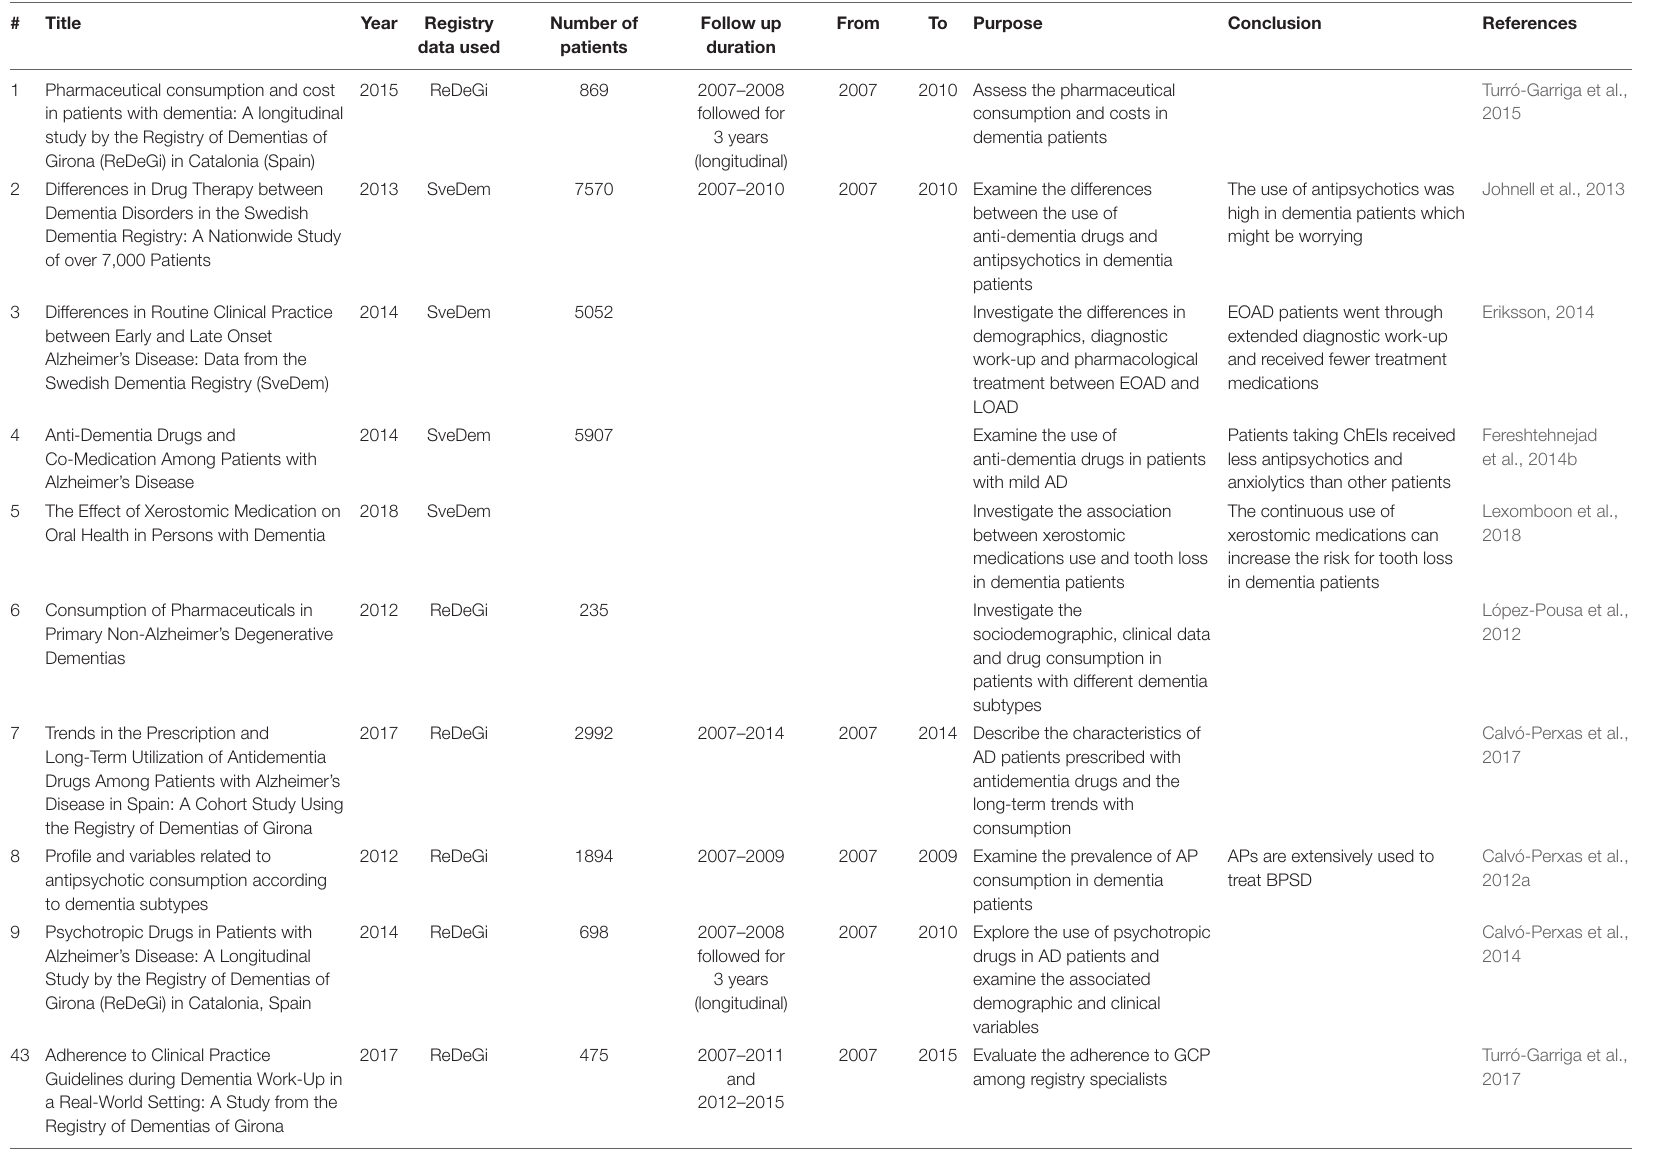
TABLE 4 | Registry-based studies on dementia